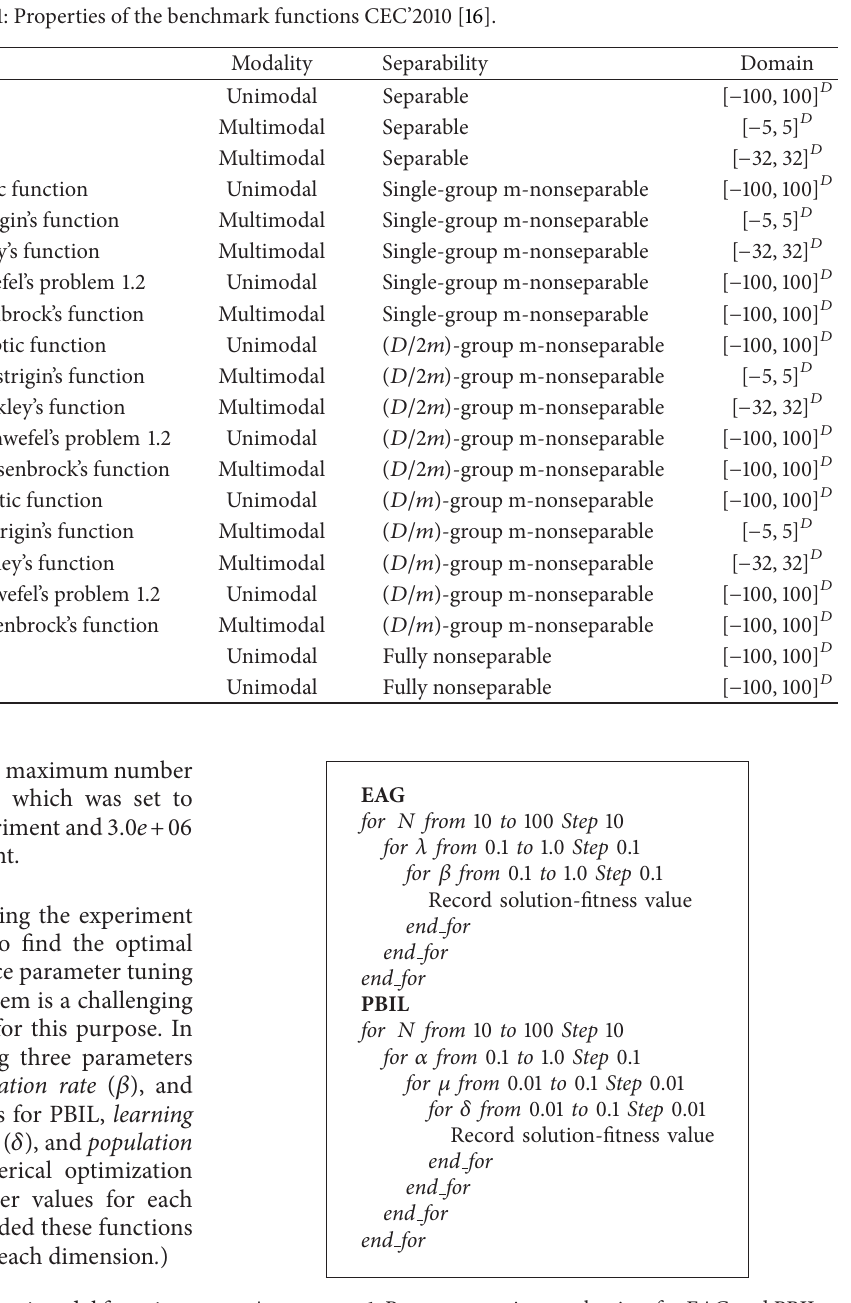
Algorithm 1: Parameter tuning mechanism for EAG and